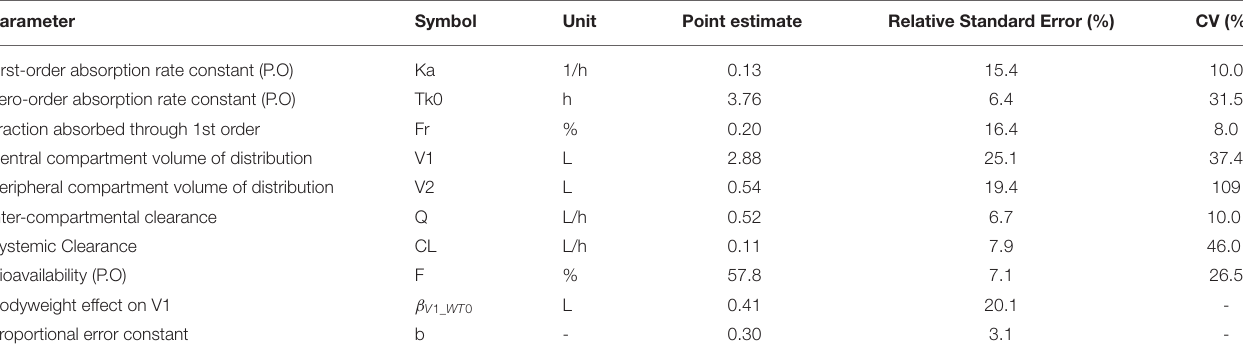
TABLE 2 | Estimated model parameters and their associated relative standard errors (RSE%) and variation (CV%) for vitacoxib pharmacokinetics in